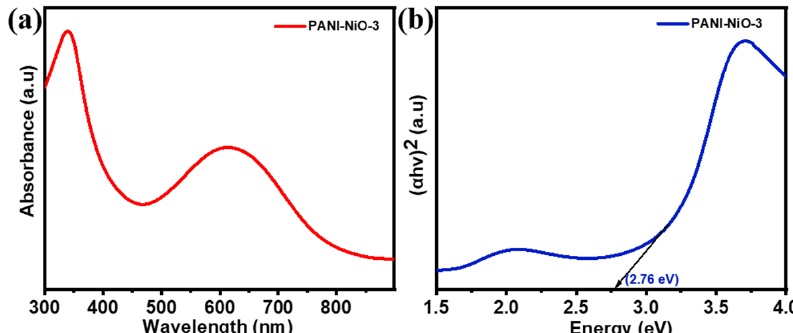
Figure 4. ( a ) UV-visible spectra, and ( b ) corresponding Tauc-plot of PANI-NiO-3.